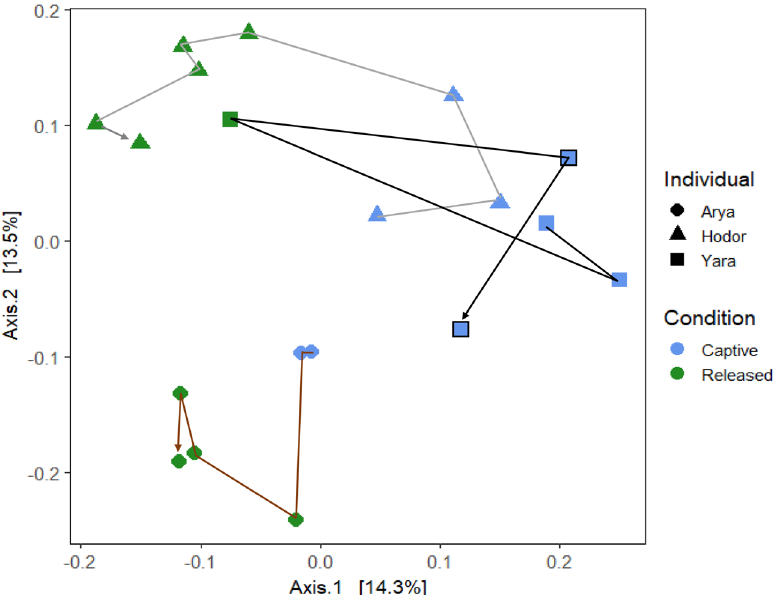
Figure 2. Unweighted UniFrac distances of 16S rRNA gene amplicons data grouping by condition and name of the individuals. Samples with a black border represent samples from an individual upon return to captivity after one month in the wild. Arrows follow the trajectory of samples from each individual over